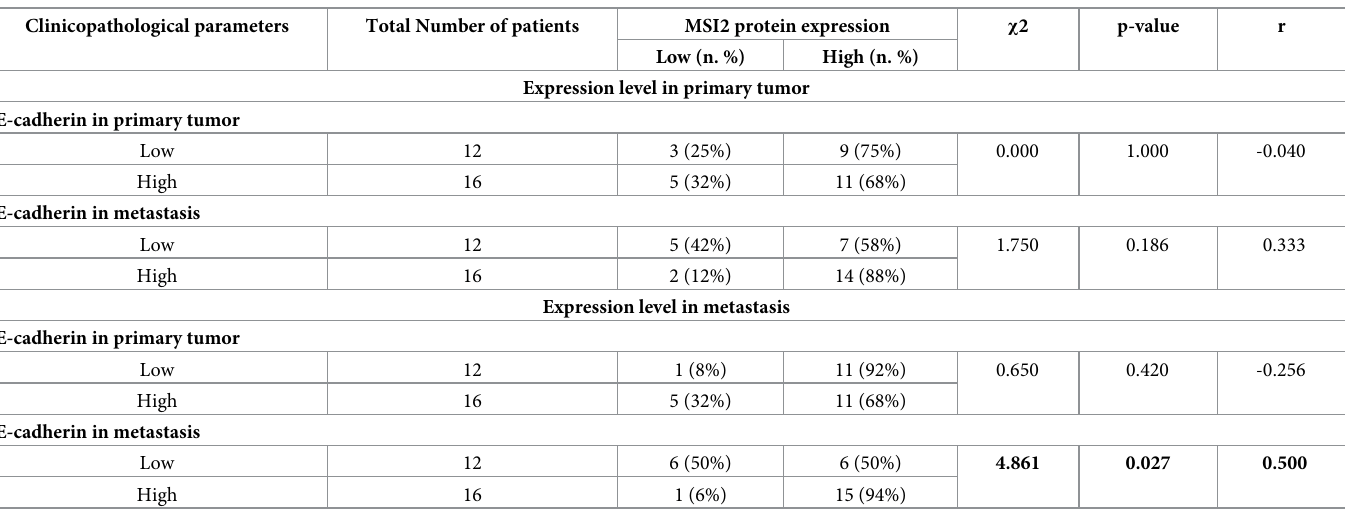
Table 4. Relationship between MSI2 and E-cadherin in CRC. Clinicopathological